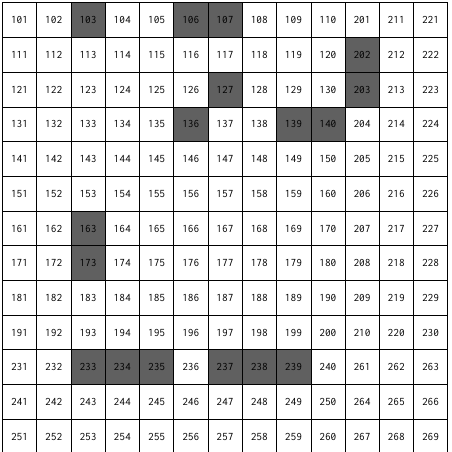
Figure 11. Layout of sites in locality M1. The 169 sites are numbered from 101 to 269. If a site has a particular microspecies then it is colour coded black, otherwise it is white.